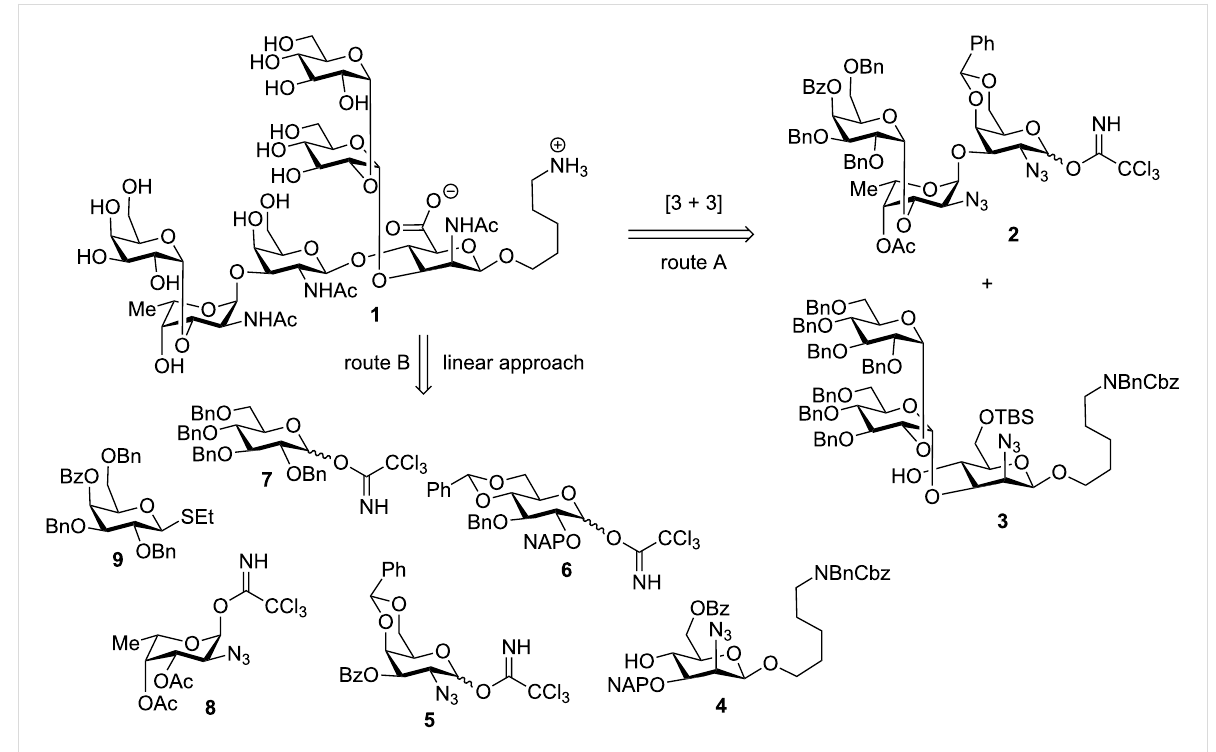
Scheme 1: Retrosynthetic analyses of the S. pneumoniae hexasaccharide 1 .